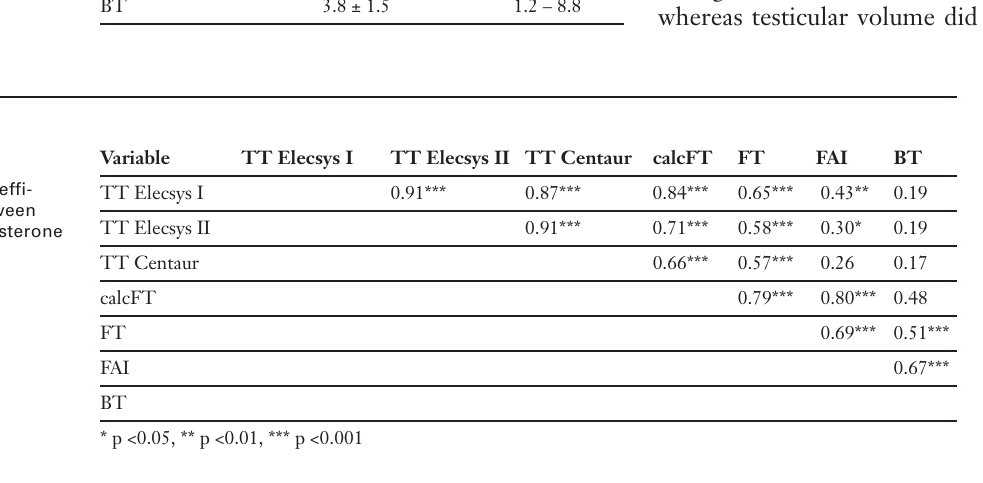
Mean values, stan- dard deviation (SD) and total range of dif- ferent testosterone measurements.